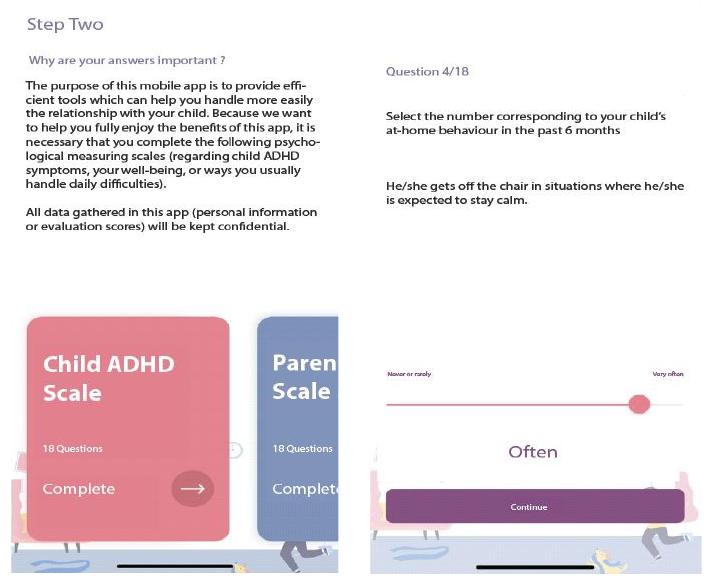
Figure 2. Assessment. Figure 2.